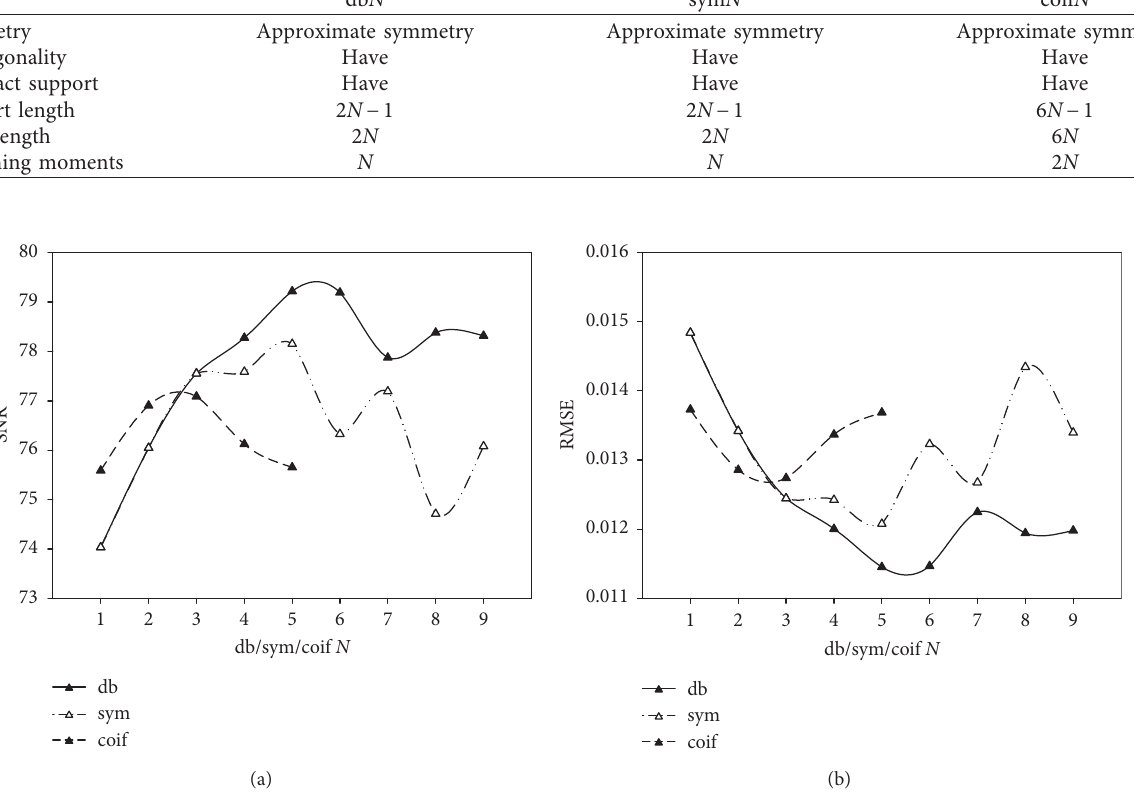
Figure 6: SNR and RMSE after denoising with different wavelet bases. (a) SNR after denoising with different wavelet bases. (b) RMSE after denoising with different wavelet bases.